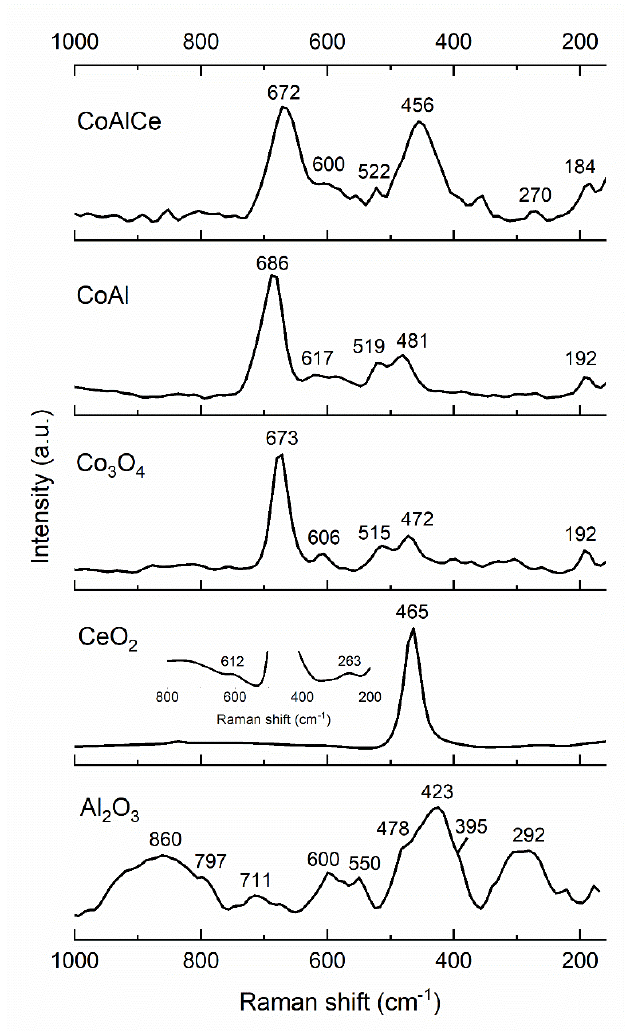
Figure 4. Raman spectra of the mixed and single oxides.